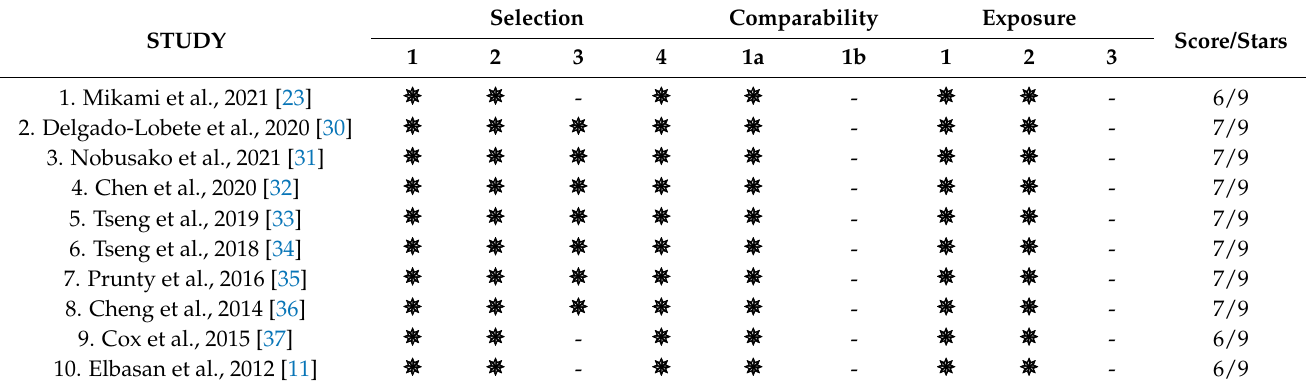
Table 1. Results of risk of bias assessment of the selected studies are based on the Newcastle—Ottawa quality assessment scale.